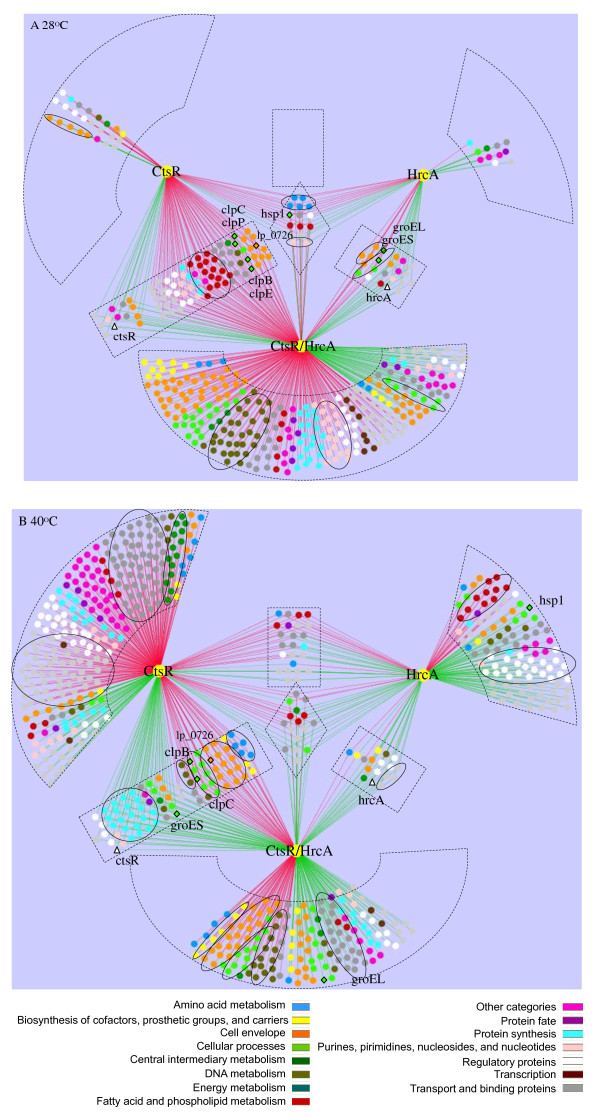
Significantly differentially transcribed genes in NZ3410 (ΔctsR), NZ3425CM (ΔhrcA), and NZ3423CM (ΔctsRΔhrcA) as compared to the wild-type grown at 28°C (A) or 40°C (B). Yellow colored octangular nodes represent the mutants and other colored nodes indicate main classes. The red and green lines indicate up- or downregulation, respectively. Triangle nodes indicate the CtsR or HrcA transcription regulator, diamond nodes indicate genes that are predicted to be part of the CtsR and/or HrcA regulon, whereas black ovals indicate over-represented main classes or subclasses in that particular main class. The main class “hypothetical proteins” was excluded.